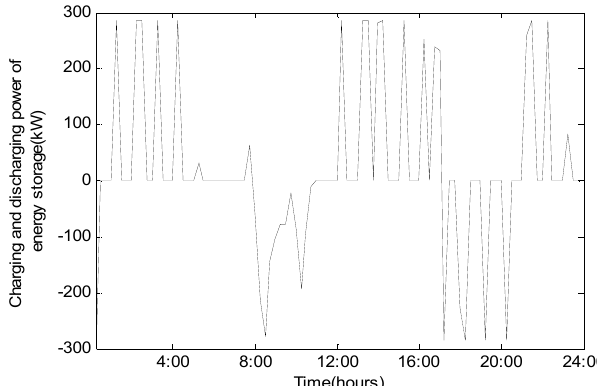
Figure 6. User load power with VRLA (Peak shaving).